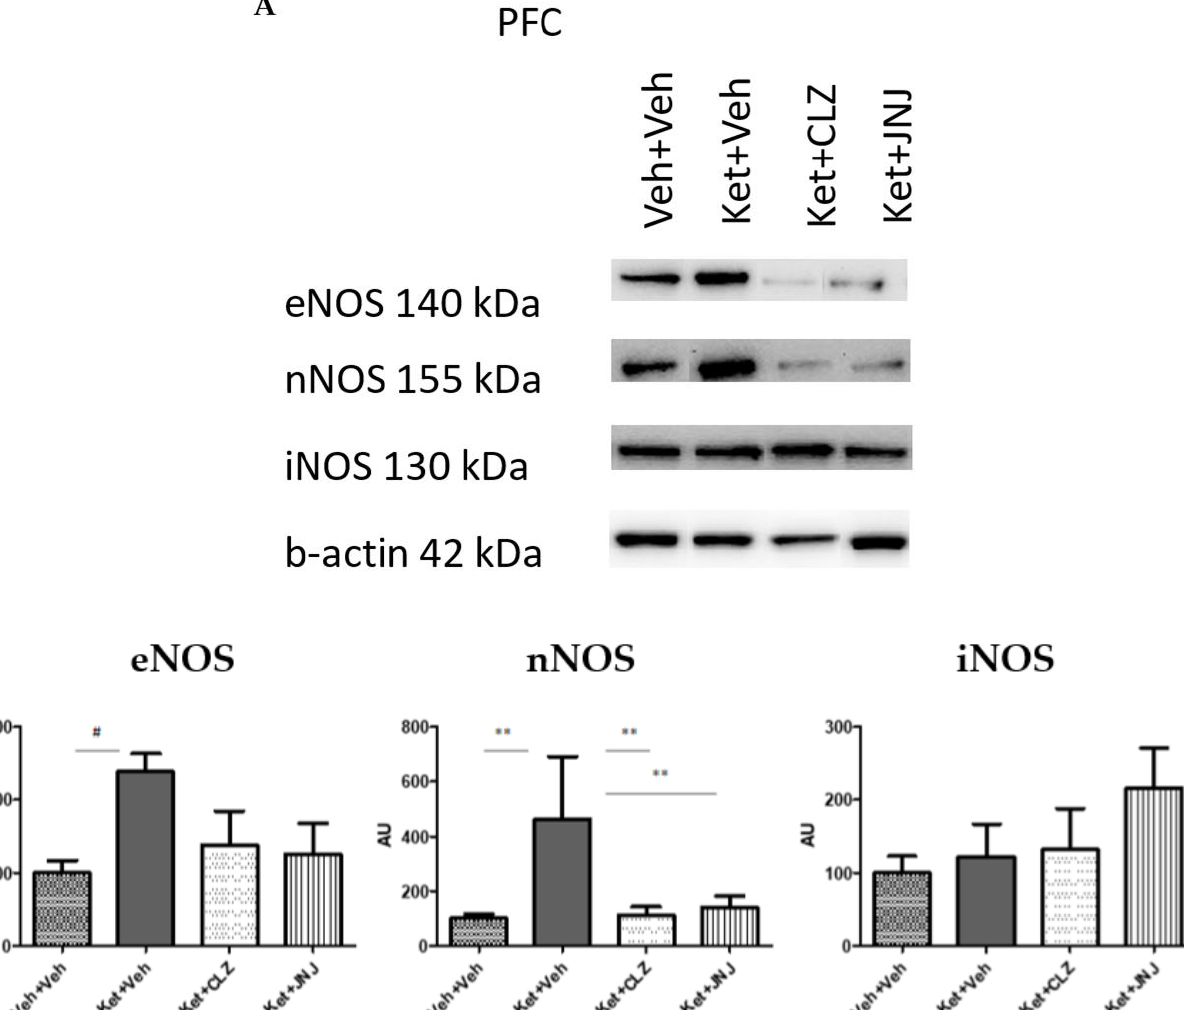
Figure 1. Effect of CLZ and JNJ treatments on protein levels of NOS isoforms in the PFC of SZ-like mice induced with Ket. ( A ) Representative densitometry blots of eNOS, nNOS, and iNOS isoforms in the PFC tissue from the different groups of study, including vehicle controls, SZ-like mice induced with Ket, and Ket-induced mice treated with CLZ or JNJ. The upper panels show the three protein isoforms of interest, and the lower panel represents the corresponding housekeeping β -Actin. ( B ) Protein levels of the three NOS isoforms (eNOS, nNOS, and iNOS) were estimated by quantification of densitometry blots (AU). Both eNOS and nNOS increased in the Ket-induced group compared to the vehicle and decreased in the CLZ and JNJ treated groups, although the decrease associated with the pharmacological treatments was only significant in the neuronal isoform. The iNOS isoform did not lead to significant differences among the groups of study. # p = 0.07, ** p < 0.01 (AU, arbitrary units; CLZ, clozapine; eNOS, endothelial nitric oxide synthase; iNOS, inducible nitric oxide synthase; JNJ, JNJ-46356479; Ket, ketamine; NOS, nitric oxide synthase; nNOS, neuronal nitric oxide synthase; PFC, prefrontal cortex; Veh, vehicle).